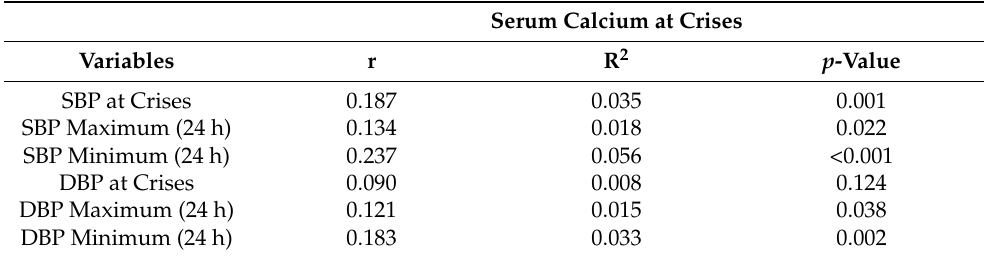
Table 7. Association of serum calcium at crises with SBP and DBP at different time points ( N = 293).